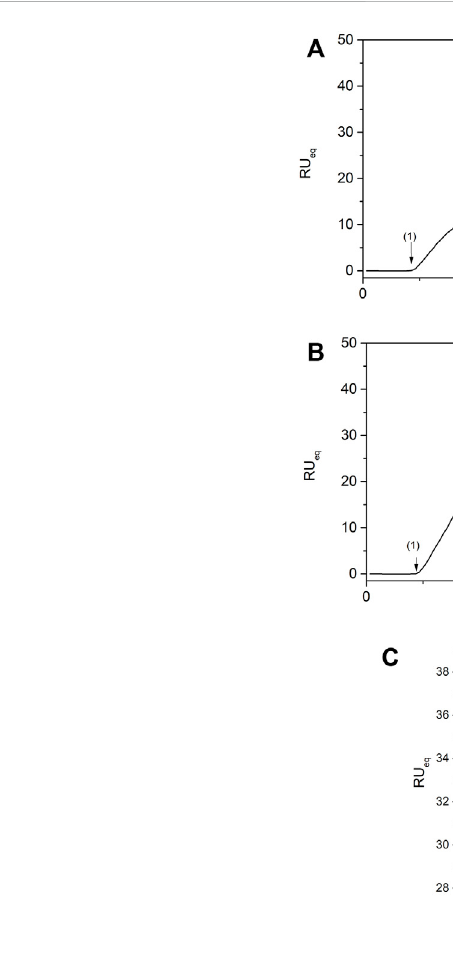
SPR sensograms for the bilayer interaction of (A) LyeTx I-b and (B) LyeTxI-bPEG. POPC:POPG LUVs (0.05 — 0.25 mM) were immobilizedon the surface of the DTT-gold sensor chip and 10 µM peptide solutions were injected at a fl ow rate of 10 ml min − 1 . (C) The dependence of RU eq intensities of (square) LyeTx I-b and (circle) LyeTx I-bPEG on lipid concentration. The numbers correspond to (1) start of LUV injection, (2) end of LUV injection, (3) start of peptide injection, and (4) end of peptide injection. Solid lines are simulations according to Eq. 2, accounting for